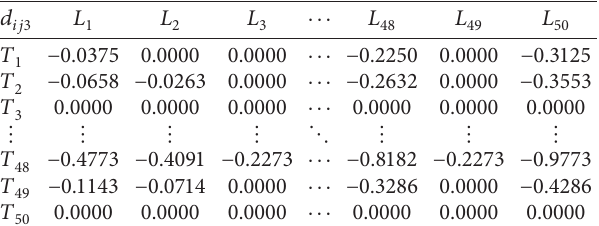
′ � [ d ij ′ ] for 3 3 50 × 50